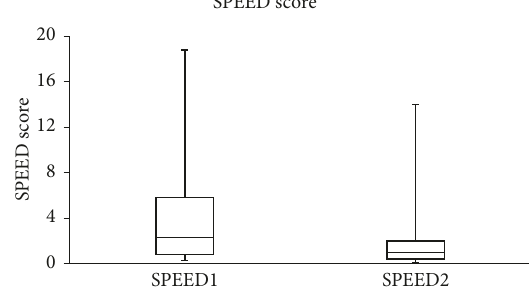
Figure 1: Side-by-side boxplots for the SPEED scores for the study group before (SPEED1) and after wearing (SPEED2) a face mask.